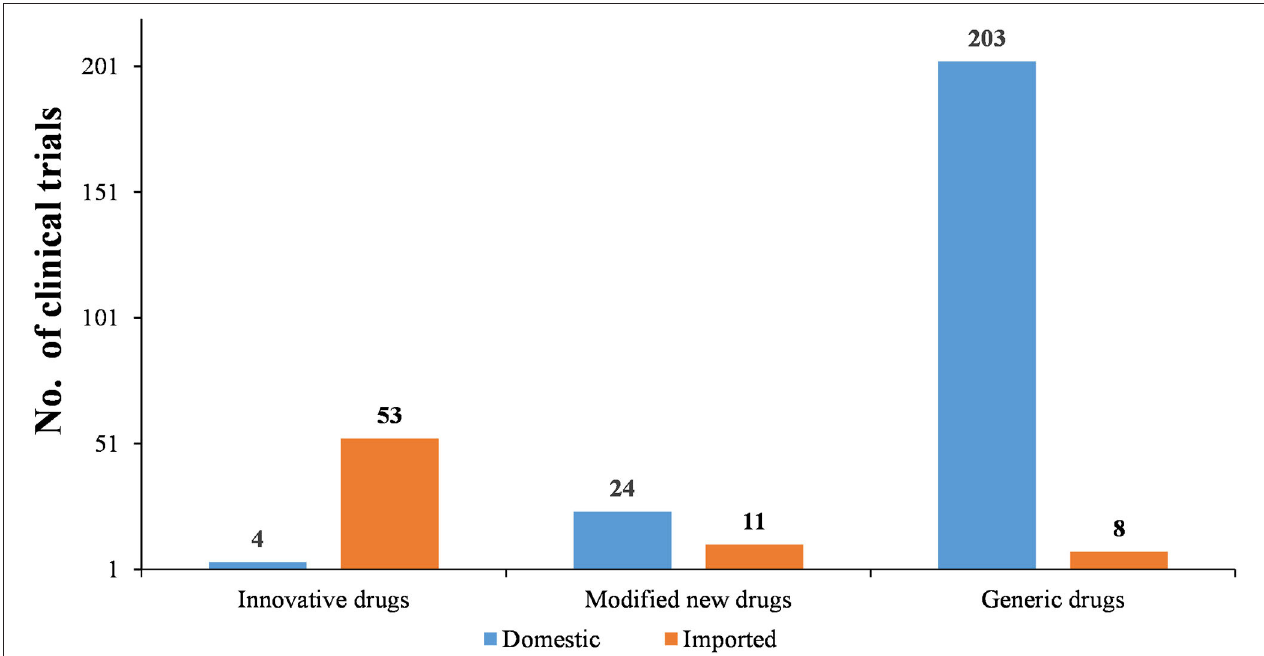
FIGURE 7 | Distribution of domestic and imported chemical drugs in pediatric clinical trials.